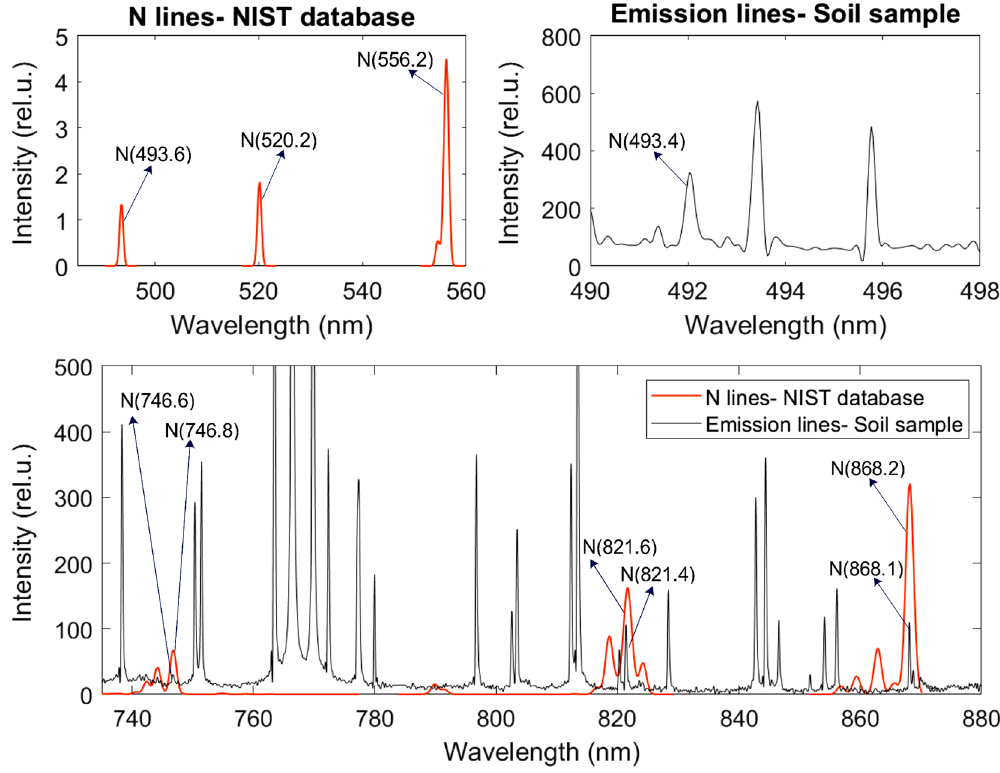
Figure 3. Determining N lines from the soil sample using NIST database.